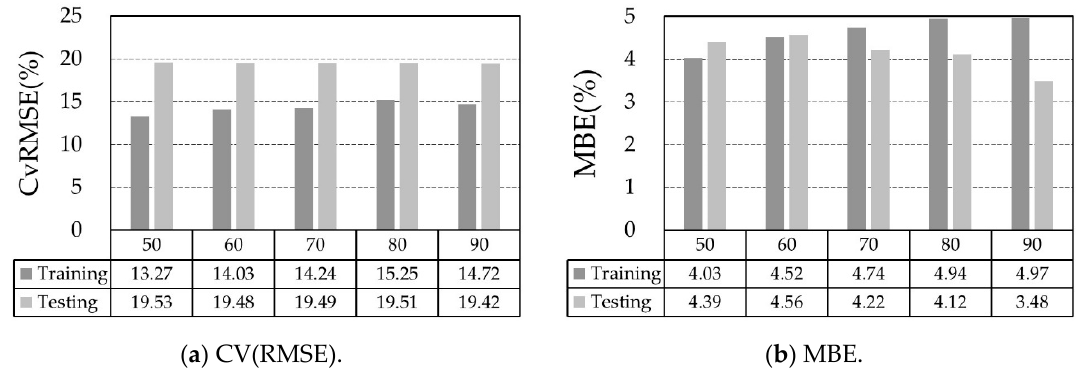
Figure 2. Accuracy of the AHU energy consumption forecasting model.